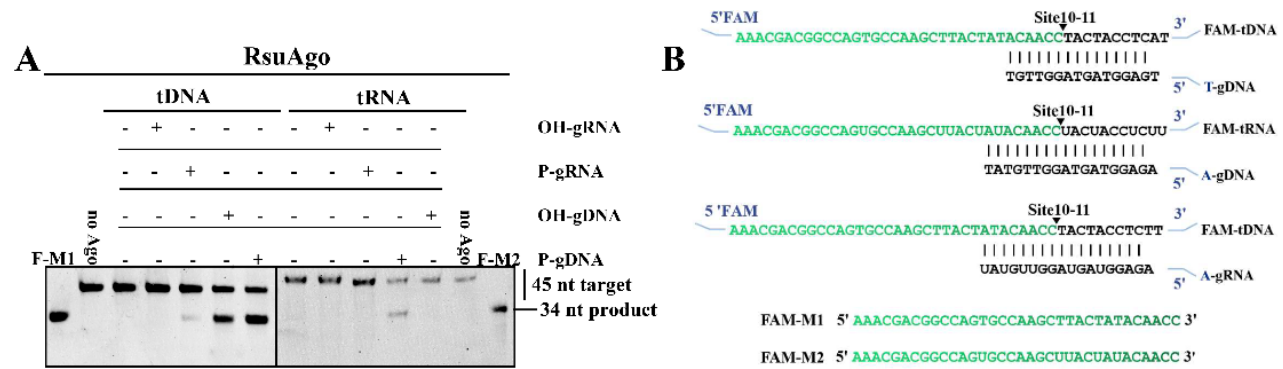
Figure 2. Analysis of single-stranded nucleic acid cleavage activity of pAgos. ( A ) Cleavage by RsuAgo with FAM-labeled DNA and RNA targets. ( B ) The sequence of the synthetic miRNA-based guide and target sequences that were used for the in vitro cleavage assays. The black triangle indicates the cleavage site. The vertical lines indicate contiguous Watson-Crick pairing. F-M1 (FAM-M1) and F-M2 (FAM-M2) are chemically synthesized, 34 nt long ssDNA (F-M1) and ssRNA (F-M2) oligonucleotides with a FAM-label at the 5 ′ -end that were loaded on gels as size markers corre- sponding to the length of the DNA and RNA cleavage products, respectively. All experiments were performed at the 4:2:1 RsuAgo: guide: target molar ratio in reaction buffer containing Mn 2+ ions for 1 h at 37 °C. All cleavage experiments were carried out in triplicates.